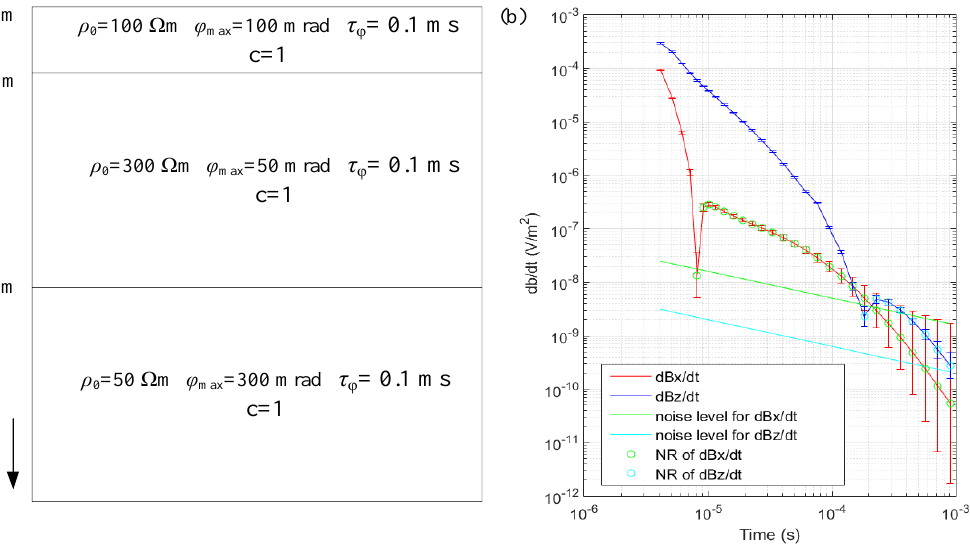
Figure 2. IP responses for a three-layer model. ( a ) The three-layer model. ( b ) The time derivatives of the magnetic fields, where red curves represent d B x /d t with the errorbar, blue curves represent d B z /d t with the errorbar; and the negative values are marked with green circles or cyan circles, respectively. Moreover, the green and cyan lines show the noise levels: b takes 1.6 and 0.2 nV/m 2 at 1 ms for x and z components, respectively. The errorbars are connected with the noise model described in Equation (2).